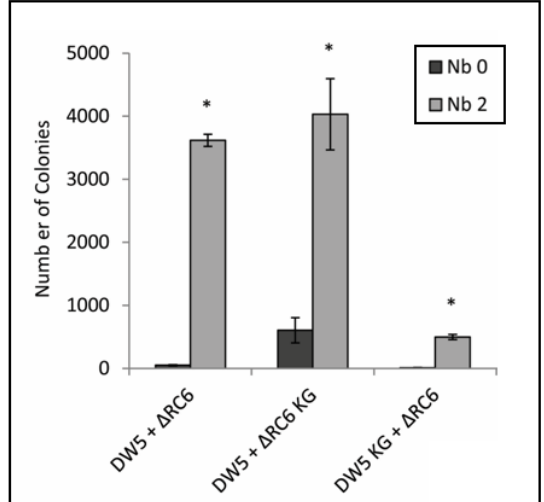
Figure 5. Transduction assays with NbR strains. Strains DW5, ∆RC6, DW5 containing plasmid pRhoKGyrB (DW5 KG), and ∆RC6 containing pRhoKGyrB (∆RC6 KG) were used. All combinations were grown with or without Nb at 2 µg/mL. Error bars indicate the standard deviation (n = 3), and * indicates p < 0.01 compared to the same mixture of strains grown without Nb.